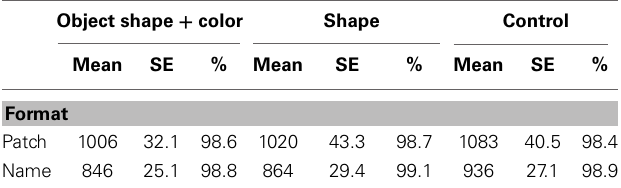
Table 1 | Experiment 1: Mean response times, standard error (SE), and percentage correct (%) for object name and color in the lexical/semantic matching task.